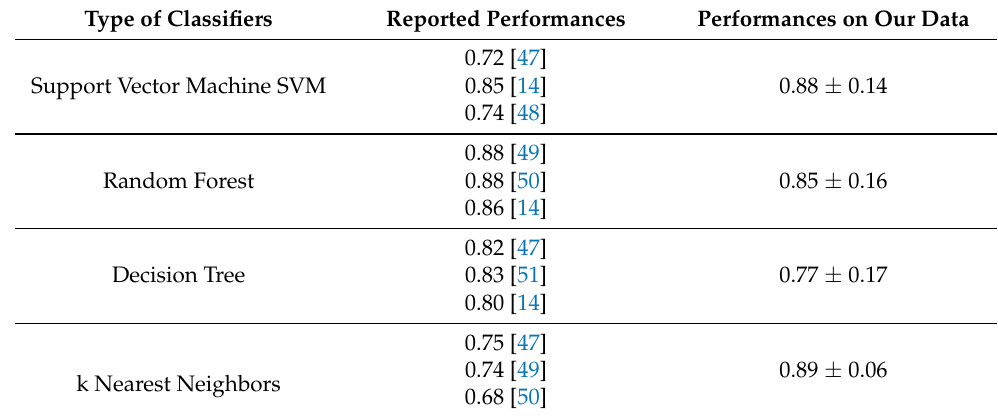
Table 4. Average accuracy values for different kinds of classifiers used in the literature to classify activities (including walking bouts) in free environments. Type of Classifiers